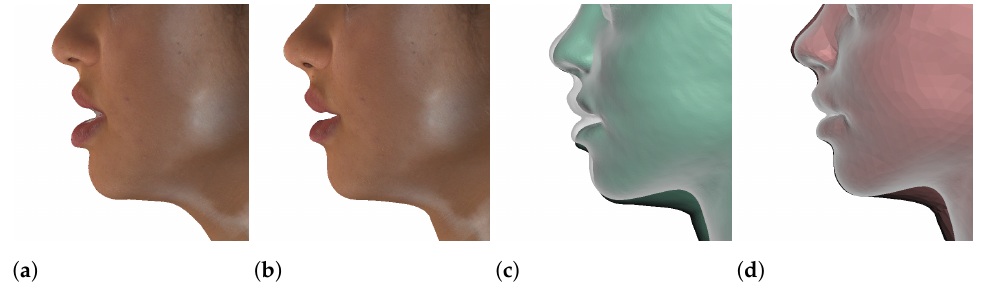
Figure 1. These images depict one of the patients (M8) of the test cohort. The first two images compare a pre-operative 3D scan ( a ) and a deformation of this scan produced by our planning simulation ( b ). Next, the pre-operative scan, in green, is overlaid with a post-operative scan, in grey, to highlight the effect of the actual surgery ( c ). The final image compares our simulation result, in brown, to the post-operative scan ( d ). In the planning simulation, 86% of the deformed surface attains an error of less than 3 mm with respect to the post-operative scan, and the error is concentrated at the neck. Moreover, this high accuracy is achieved with an FEM simulation that takes less than 4 s to